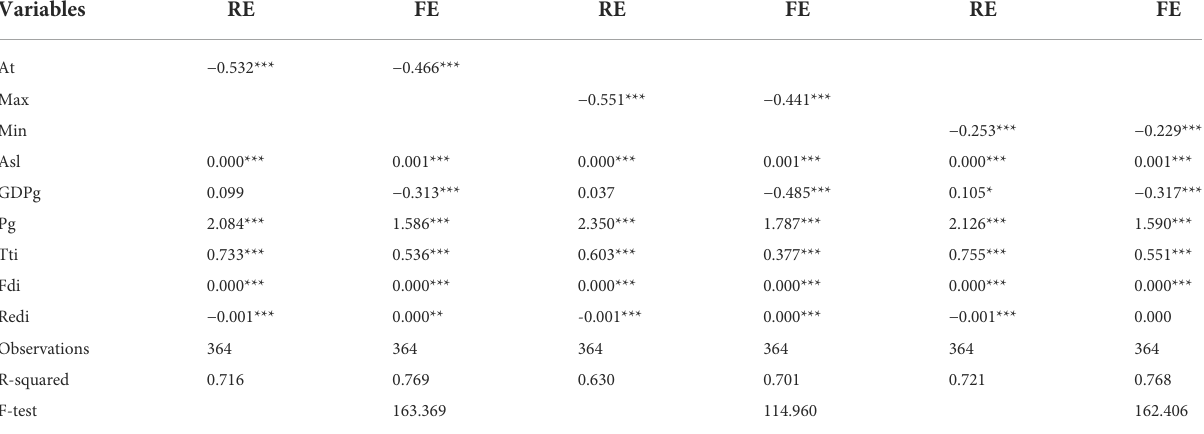
TABLE 7 Regression analysis results.